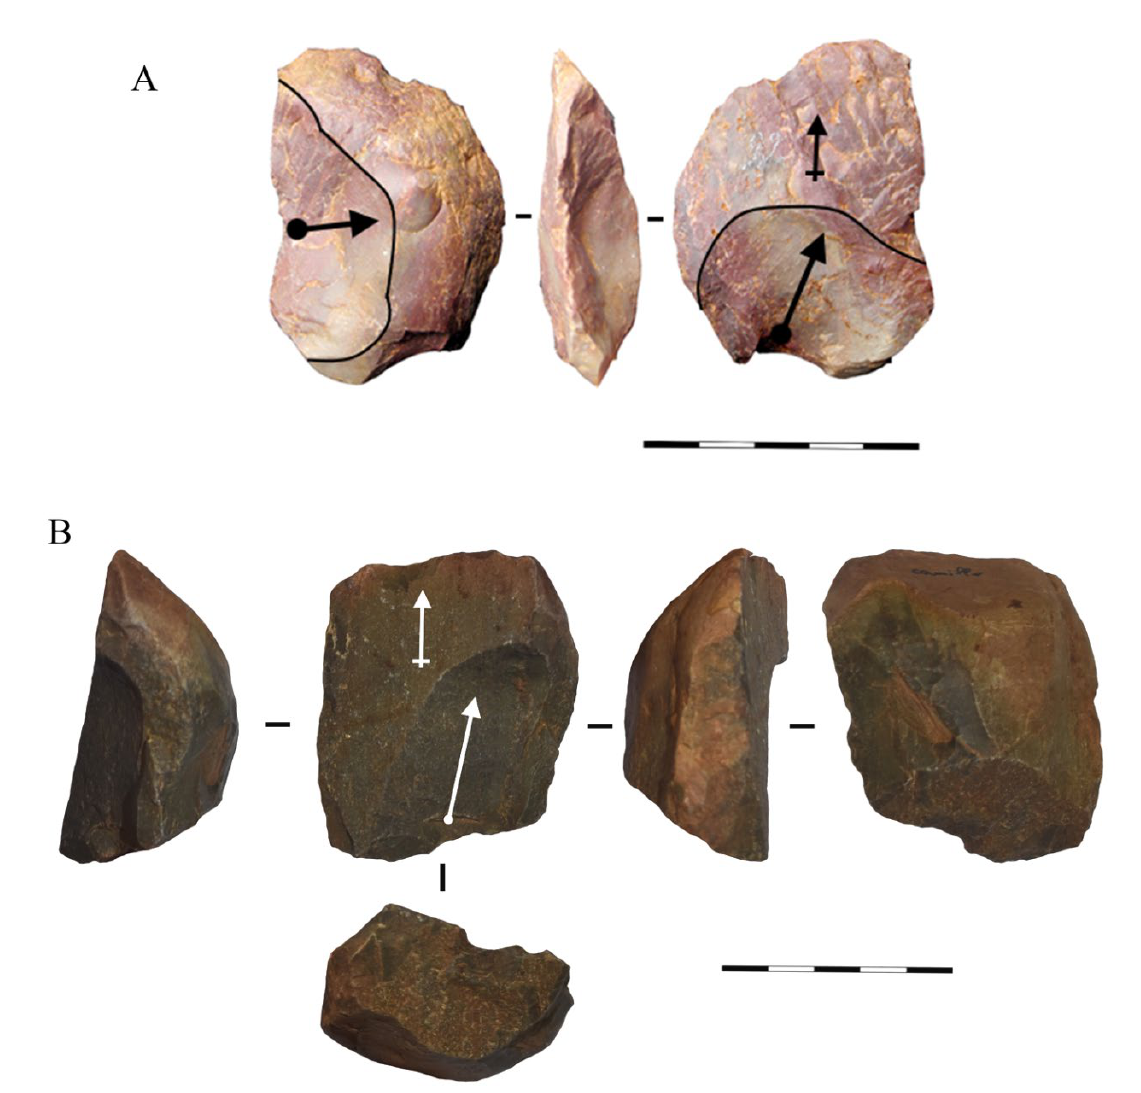
Figure 12. Cores-on-flakes on quartzite of Camillo. A: Ventral (Kombewa lineal) and dorsal (notch-like removal) exploitations; B: Kombewa lineal exploitation. Scale bar: 5